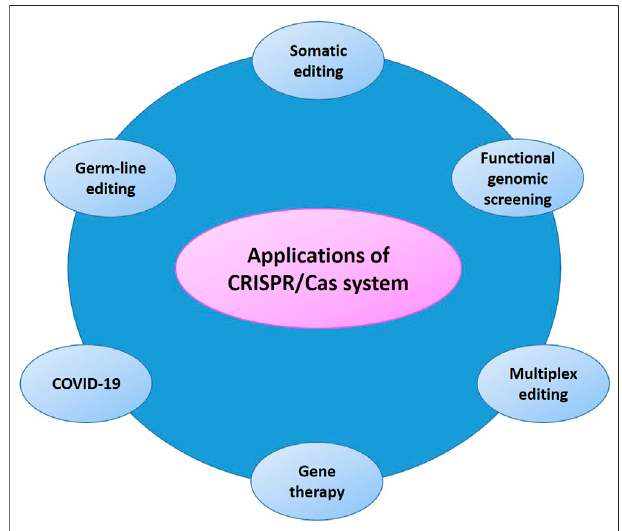
FIGURE 6 | Applications of CRISPR/Cas